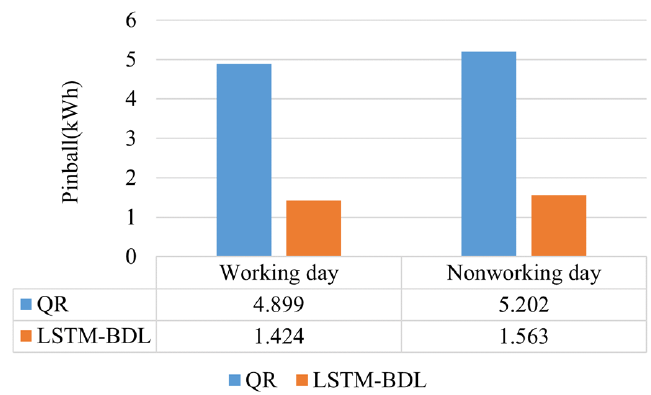
Figure 6. The average pinball loss across working days and nonworking days.